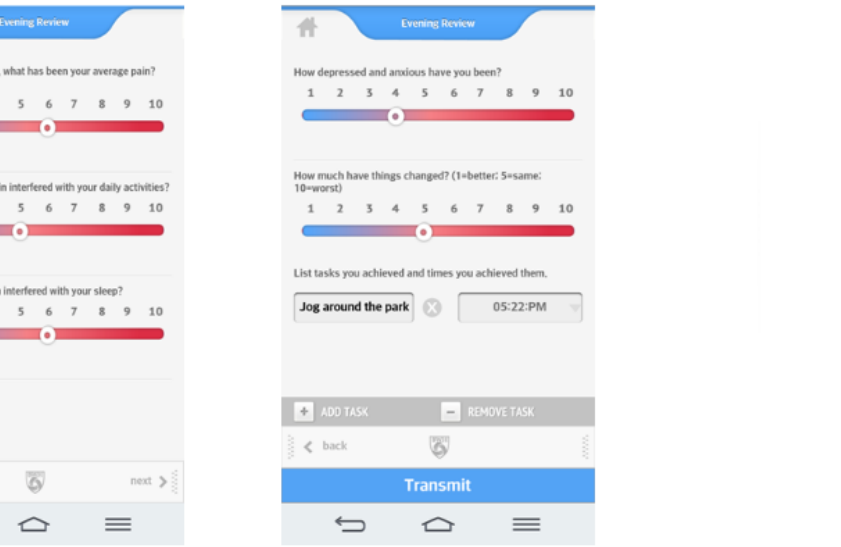
Figure 3. Pain app version 3 daily assessments and goal-setting